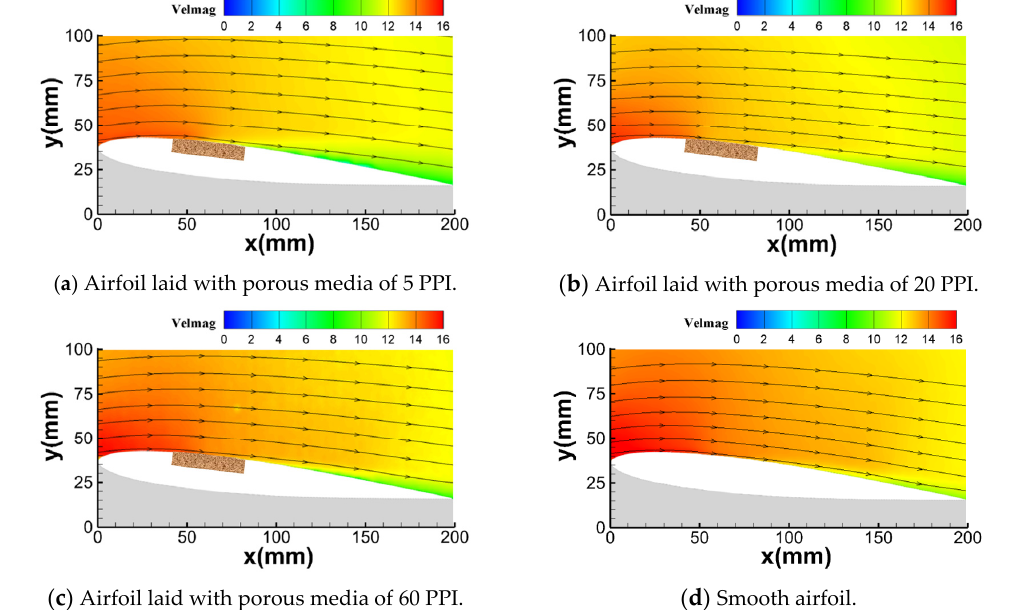
Figure 7. Time-averaged results of velocity field (AOA = 6).